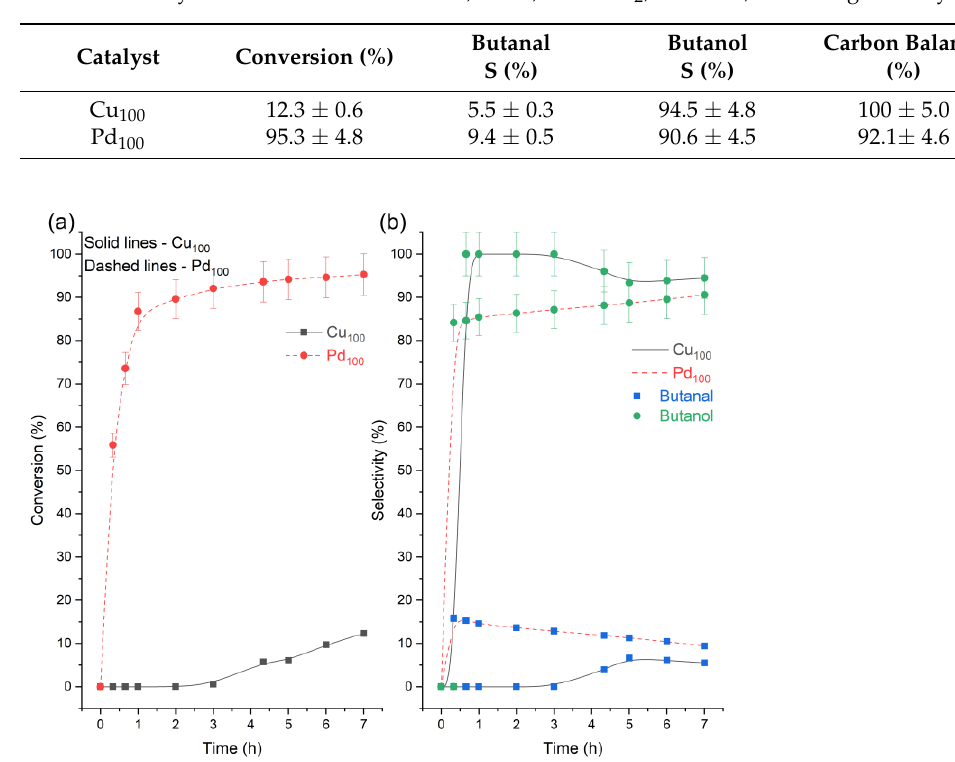
Table 3. Summary of the catalytic data for the hydrogenation of crotyl alcohol using monometallic Pd and Cu catalysts. Reaction conditions: 7 h, 50 ◦ C, 1.5 bar H 2 , 600 RPM, and 10 mg of catalyst.